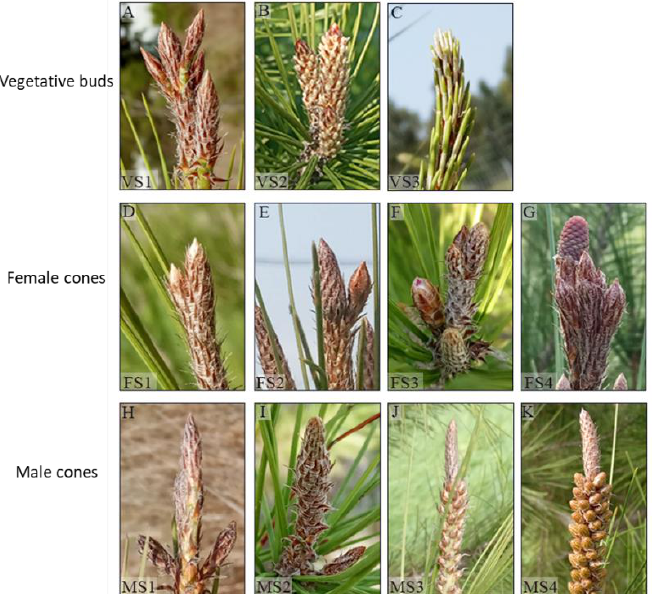
Figure 1. Developmental stages of vegetative buds, and female and male cones in P. halepensis . ( A – C ) Vegetative buds at stages 1–3. ( A ) VS1, Early vegetative buds. ( B ) VS2, Dwarf shoots are visible. ( C ) VS3, Needles are visible. ( D – G ) Female cones. ( D ) FS1, Tightly enclosed bud. ( E ) FS2, Elongated and swelled bud. ( F ) FS3, Cone emergence through the top of the scales. ( G ) FS4, A visible cone. ( H – K ) Male cones. ( H ) MS1, Tightly enclosed bud. ( I ) MS2, Apparent buds. ( J ) MS3, Cone emergence from the scales. ( K ) MS4, Fully developed cones.